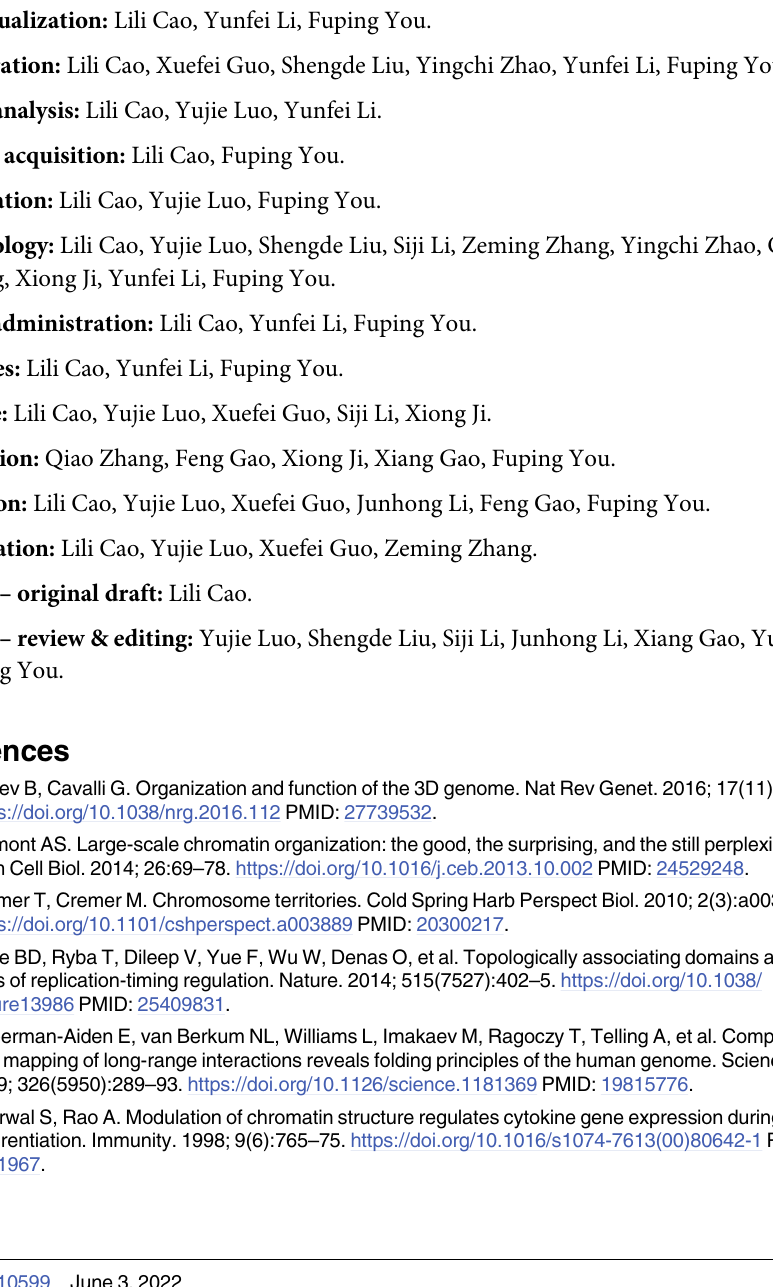
S3 Table. Primers for ATAC-qRT-PCR. S4 Table. Primers for